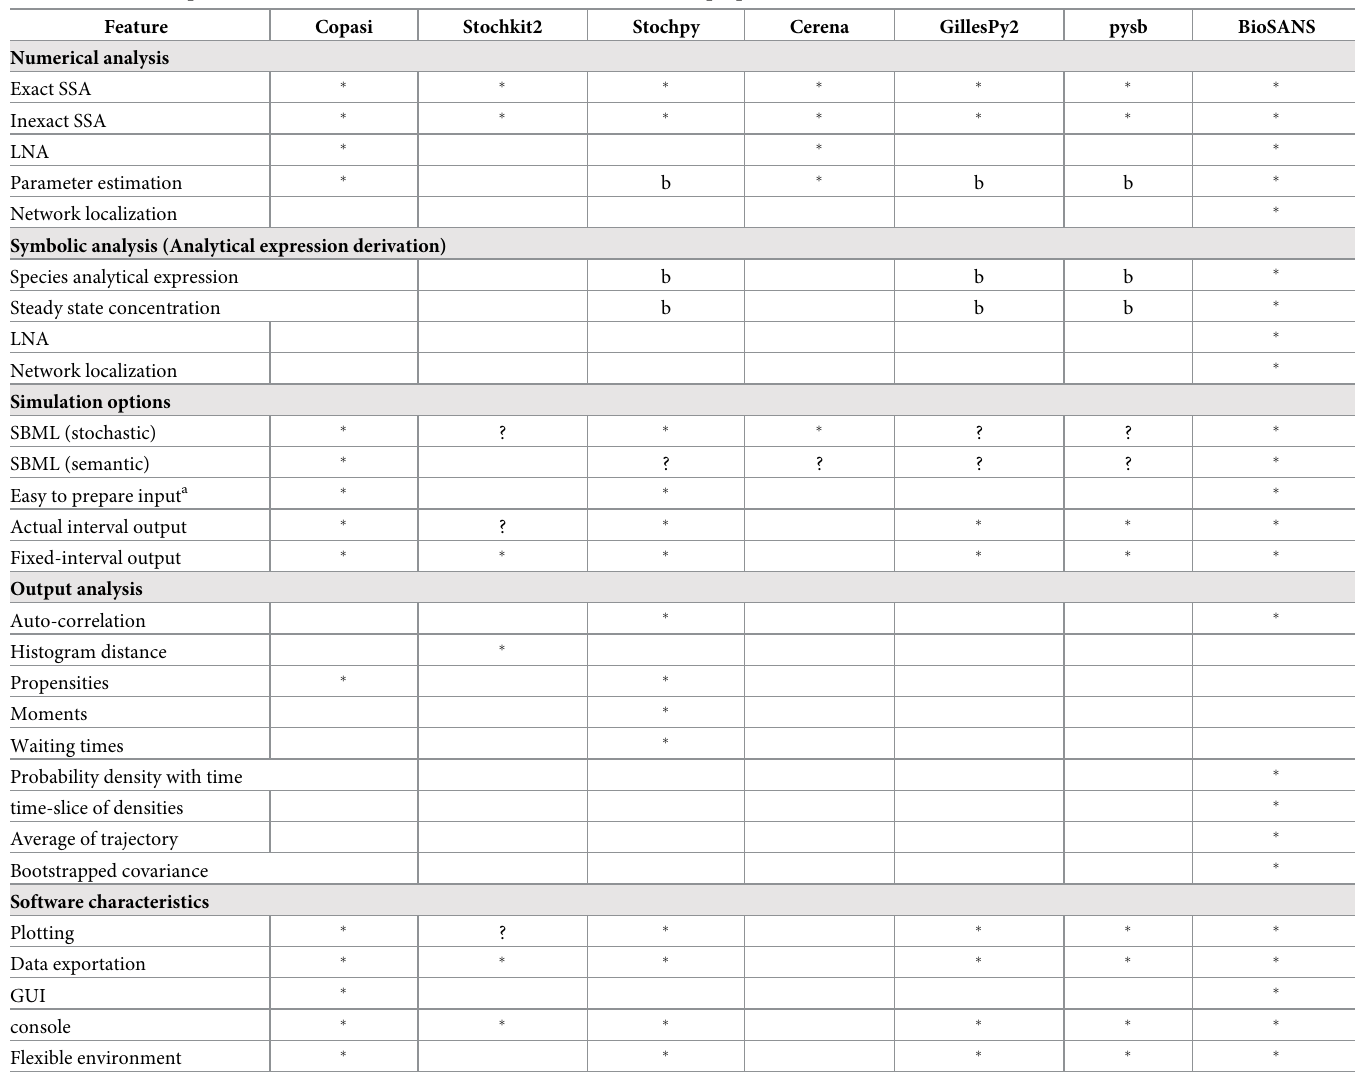
Table 1. Feature comparison between BioSANS and selected software with a similar